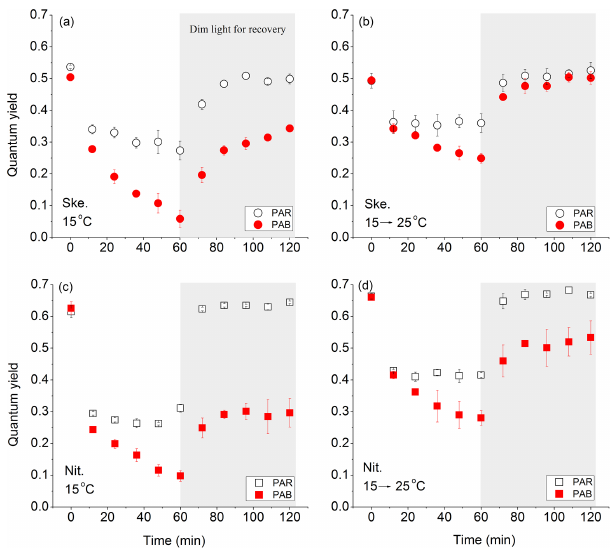
Figure 1. The quantum yields of 15 ◦ C grown Skeletonema sp. and Nitzschia sp. under PAR or PAR + UVR (PAB) for 1h exposure and subsequent recovery under dim light (gray area) for 1h, which were incubated and measured at 15 ◦ C ( a Skeletonema sp., c Nitzschia sp.) or 25 ◦ C ( b Skeletonema sp., d Nitzschia sp.). Vertical lines represent SD, n = 3.